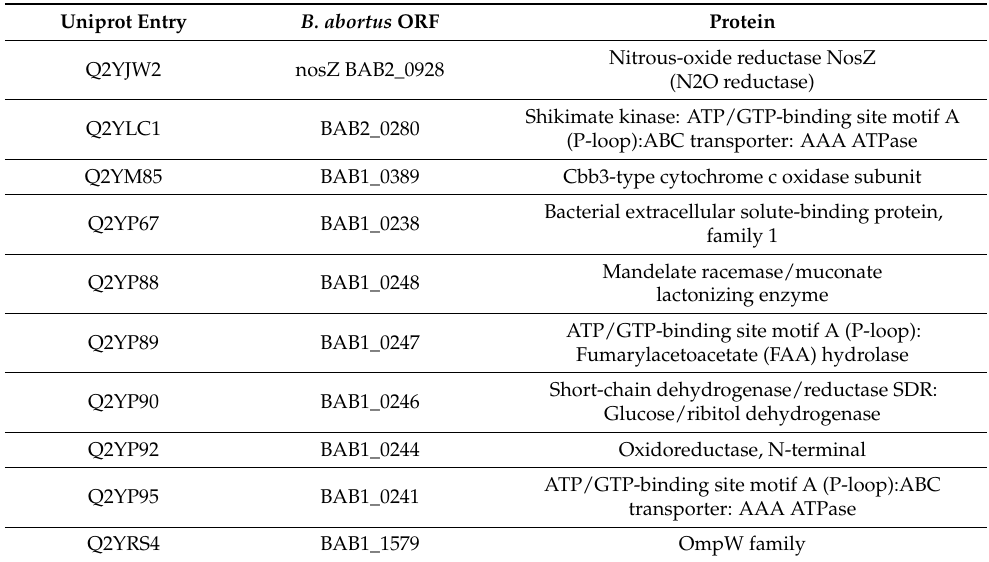
Table 2. List of proteins differentially represented between B. abortus wild type and rhomboid mutant detected in TSB and RPMI-grown